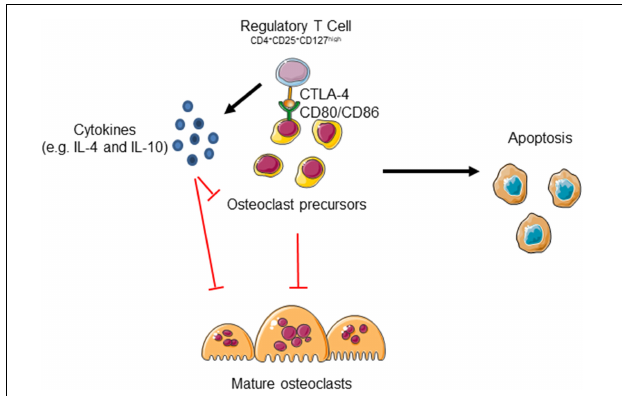
FIGURE 6 | Regulatory T cells could inhibit osteoclast formation by two mechanisms. Treg cells release several cytokines including IL-4 and IL-10 that inhibit osteoclast formation. Moreover, the binding of Cytotoxic T Lymphocyte-associated antigen 4 (CTLA-4) to CD80/CD86 receptor expressed on osteoclast precursors (pOC) induces pOC’ apoptosis. The figure was produced using Servier Medical